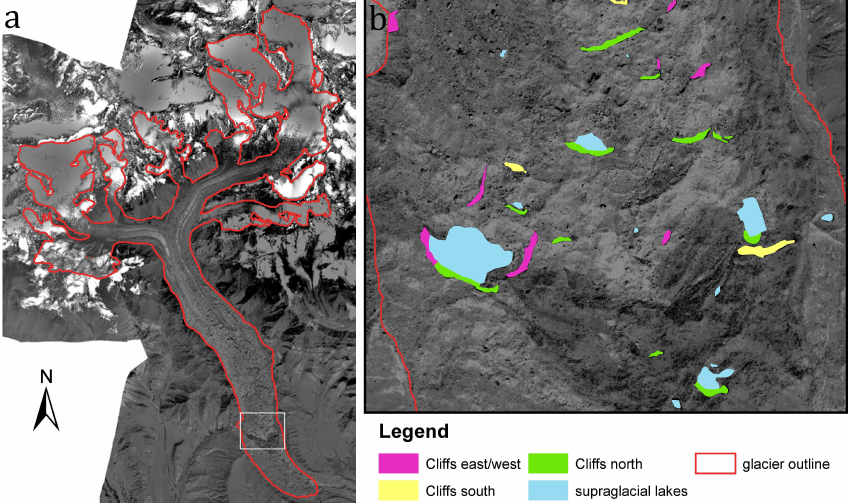
Fig. 3. (a) Overview of the study area with glacier outlines. (b) Detail of the glacier tongue. Ice cliffs and supraglacial lakes have been mapped manually (source: orthorectified Ikonos image).